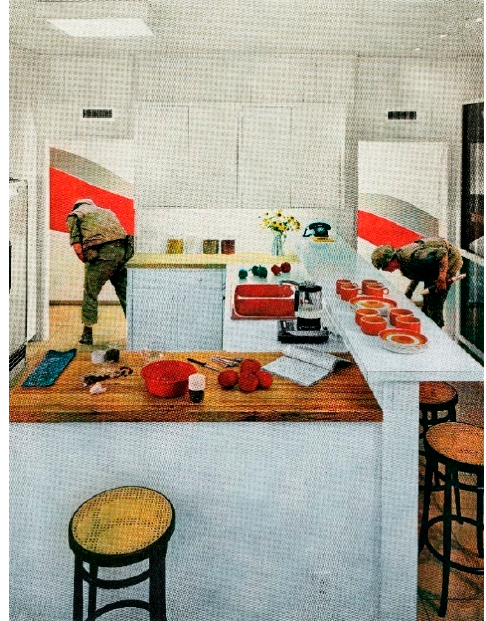
Figure 1. Martha Rosler, Red Stripe Kitchen , from the series House Beautiful: Bringing the War Home , c. 1967–1972. Photomontage. © Martha Rosler/Courtesy of the artist and Mitchell ‐ Innes & Nash, New York.